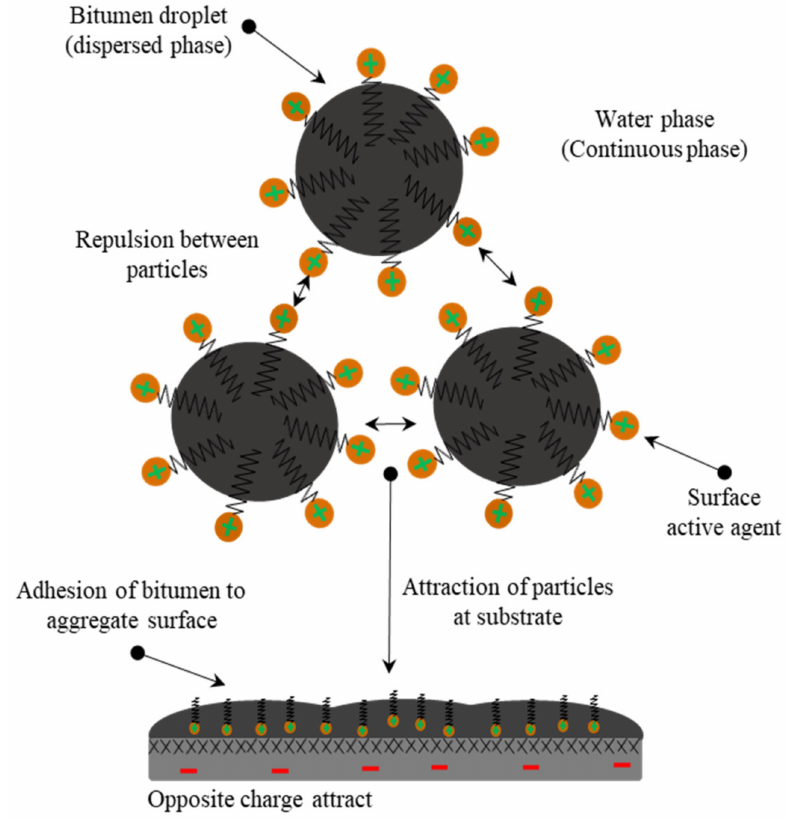
Figure 5. Schema of bitumen emulsion droplet changes adapted from